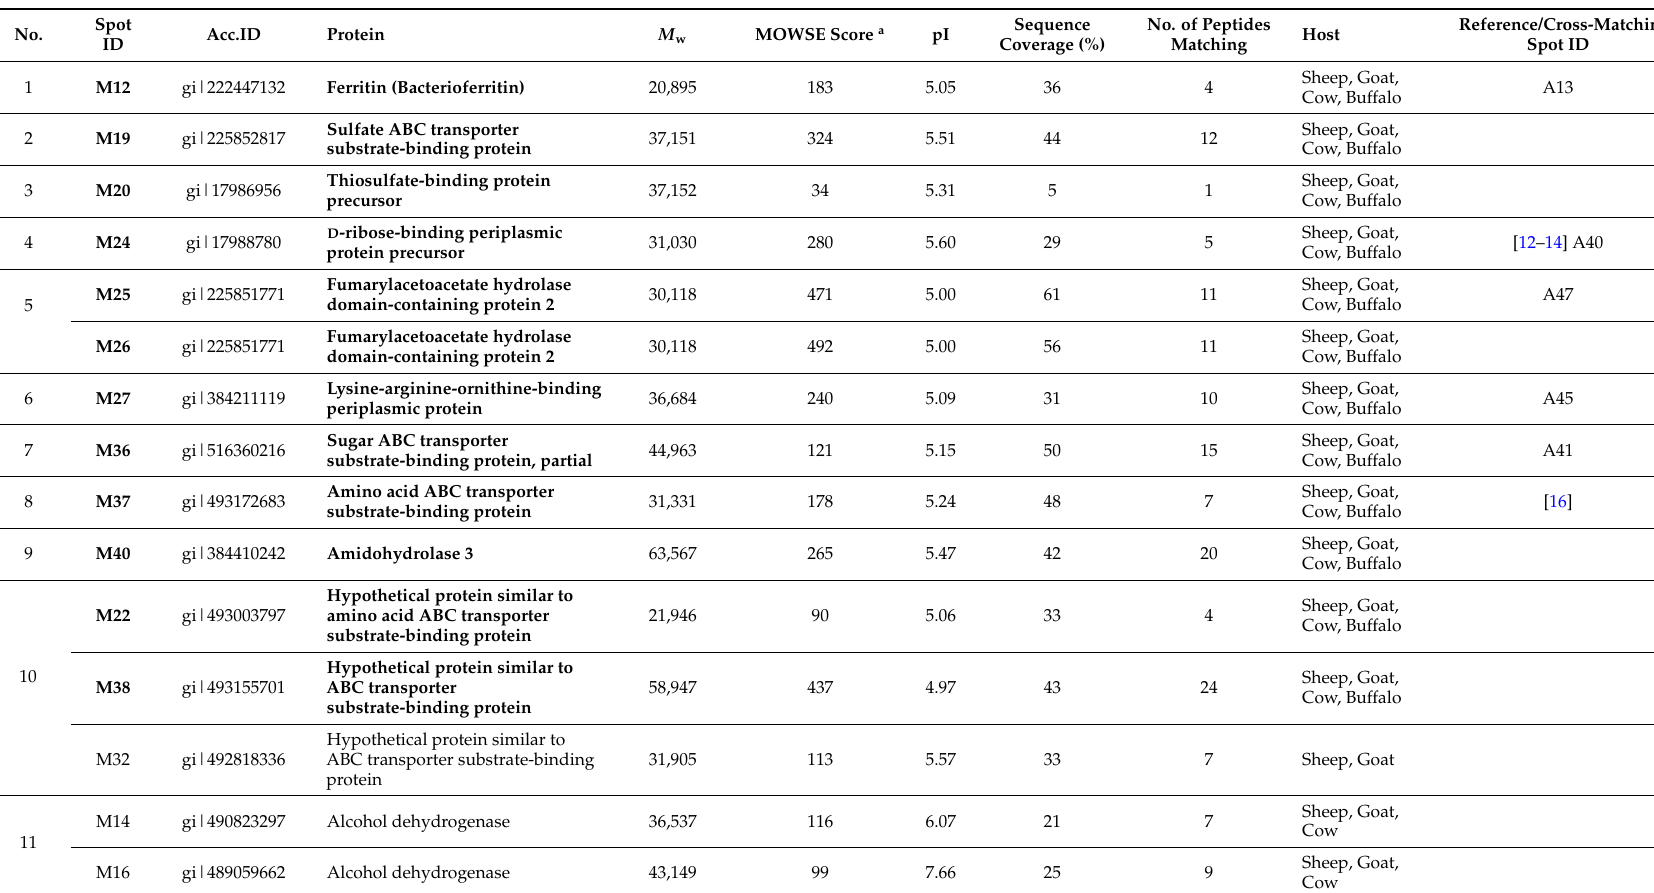
Table 2. Immunoreactive proteins from B. melitensis using 2D-PAGE Western blot and MALDI-TOF-MS. Spot ID: Spot identification; A: B. abortus ; M: B. melitensis ; Acc.ID: Accession number at NCBI; sequence in NCBI databank; Proteins: Description as in the NCBI database and the bold highlighted proteins were those considered as a promising candidate for future sero-diagnostics assays; M w : Molecular weight; MOWSE score: ´ 10*Log ( p ), where p is the probability that the observed match is a random event. This list includes only bands with a MOWSE score greater than ( p <0.05); pI: Isoelectric point; Sequence coverage (%): Is the percentage of peptide that covers the complete sequence of the protein; No. of peptides matching: Is the number of peptides that matched with the protein sequence.